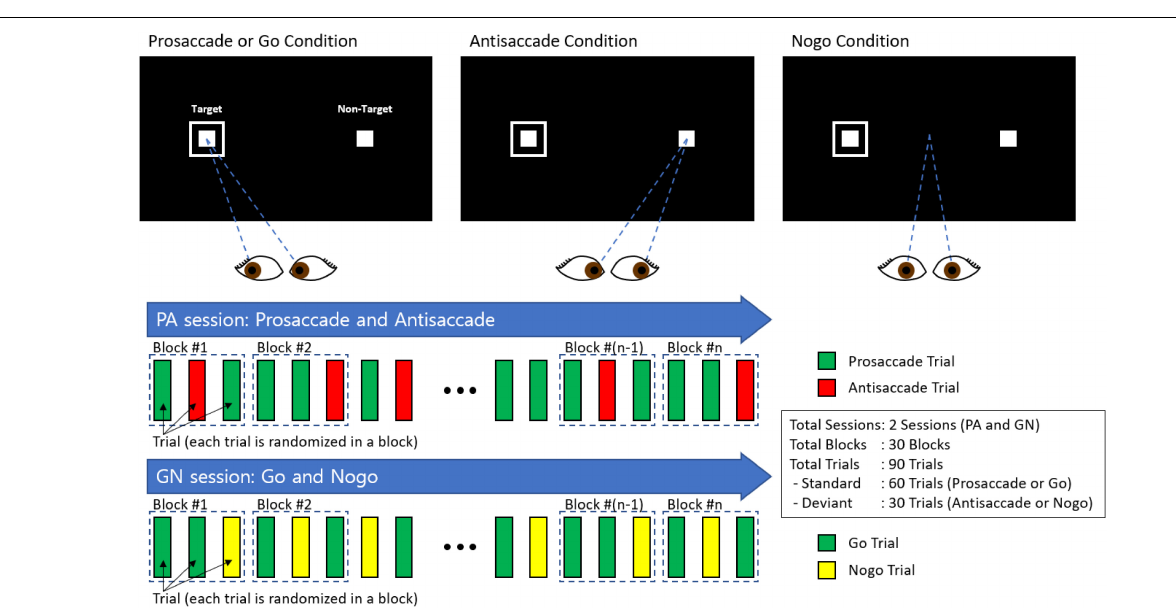
FIGURE 2 | PS/AS and Go/No-go